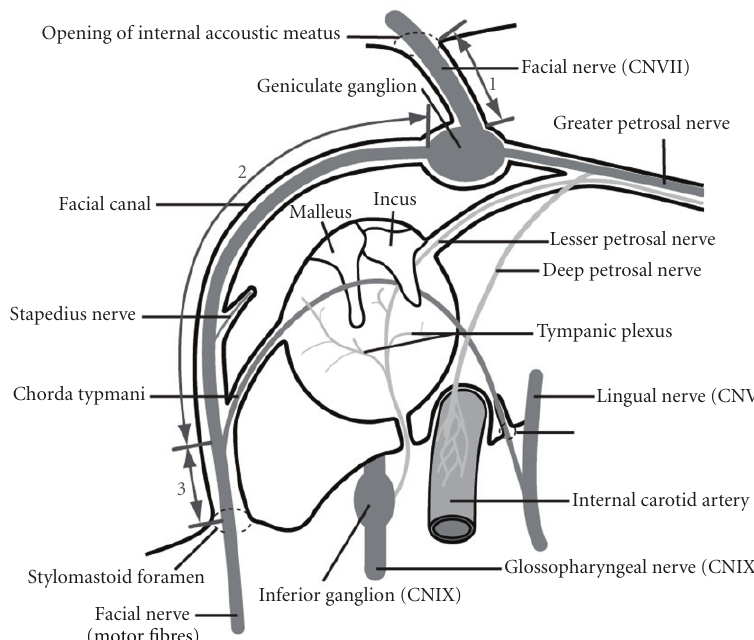
Figure 2: The sections of the facial nerve between the internal acoustic meatus and the stylomastoid foramen. Section 1: nerve in internal acoustic meatus, section 2: upper portion, section 3: lower portion.